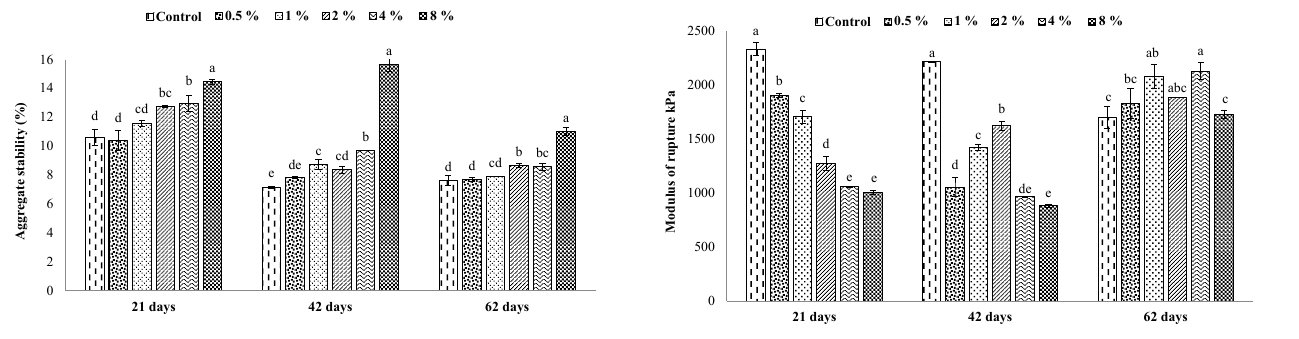
Figure 3. Effects of different rates of SMC application on soil mod- ulus of rupture (mean ± SD<0.05). Means followed by the same letter are not statistically different as determined by a least signifi- cant difference